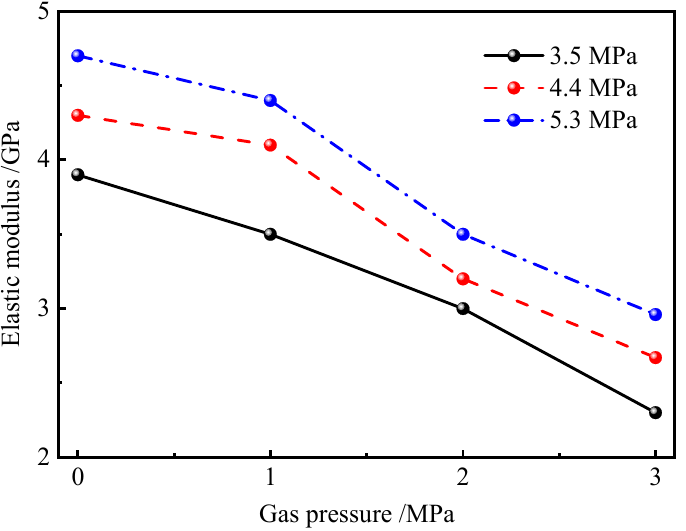
Figure 6. Evolution of the elastic modulus with gas pressure under different confining pressure